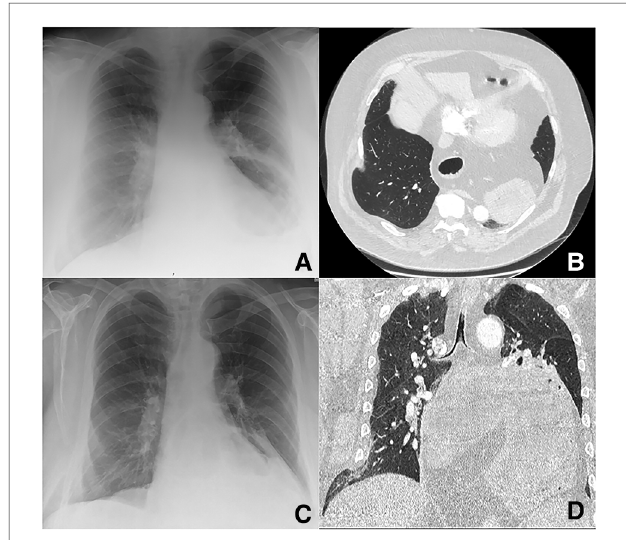
FIGURE 1 67-year-old man of BMI 42.5 who failed SLIH conservative